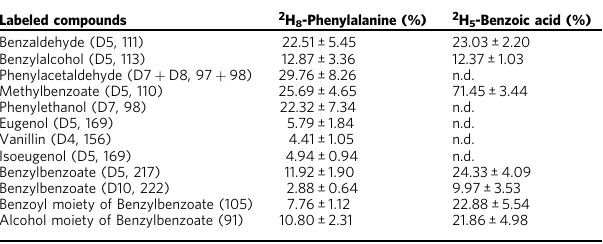
Shown are percentage of labeling,means±SE, n = 3 biologicalreplicates; n.d., notdetected. The data were calculated based on peak areas integrated from extracted ion current (EIC) chromatograms of labeled (number of additional mass units, m / z used for calculation, as indicated in the brackets) and unlabeled